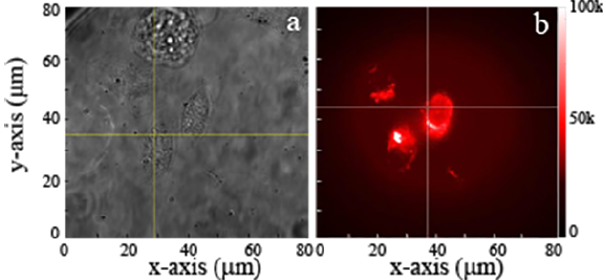
Figure 9. Prostate cancer cells and healthy cells ( a ) bright field and ( b ) widefield fluorescence of cells cultured with commercial MgO NPs; Cancer cells were stained with Alexafluor 594 without MgO NPs.